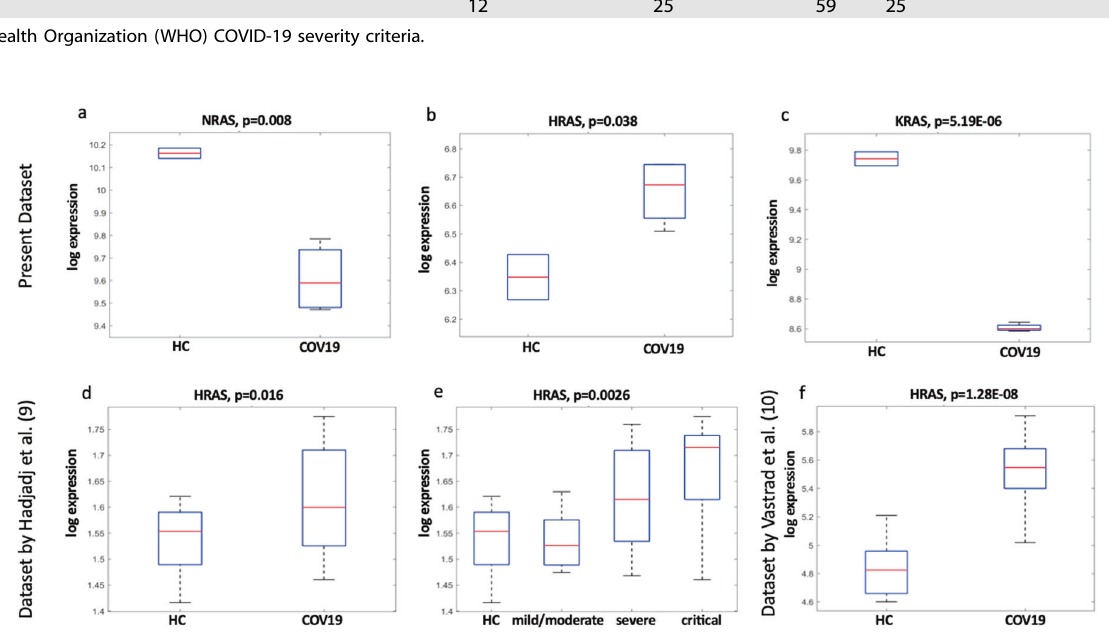
Fig. 1 Ras genes expression in COVID-19 patients. The expression of H- Ras genes is reported in log-expression units for the three different dataset ( b , d , e , f ). Data regarding N- and K-Ras are available only for our dataset and were not present in the immunology panels used for the analysis of the other datasets ( a , c ). Statistically signi fi cant differences in the expression of Ras genes between healthy controls (HC) and COVID-19 patients (COV19) are